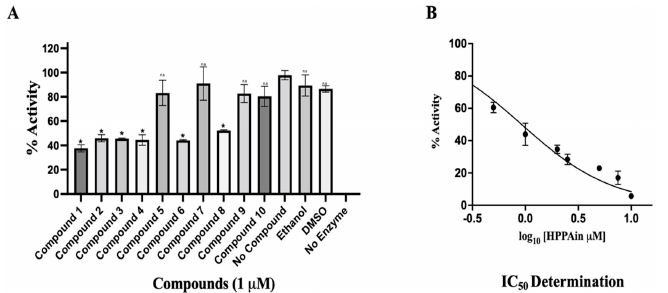
Figure 5. Cell-free inhibition assay and IC 50 determination of HPPA: ( A ) The graph represents the % of HEV-MTase activity in different compounds concerning compound-free control. The no compound control was taken as 100% MTase activity, and no enzyme control was taken as 0% activity of HEV-MTase. The inhibition assay was performed in triplicates, and the error bar indicates the standard deviation. The statistical analysis was performed using a student t -test, and a p -value < 0.005 was considered statistically significant. * p < 0.0001; n.s p > 0.005. ( B ) The graph represents the mean value of triplicate measurements for IC 50 determination. GraphPad Prism was determined by fitting the curve using log(inhibitor) vs. normalized response. The error bar indicates the standard deviation. The determined IC 50 for HPPA was 0.932 ± 0.15 μ M.